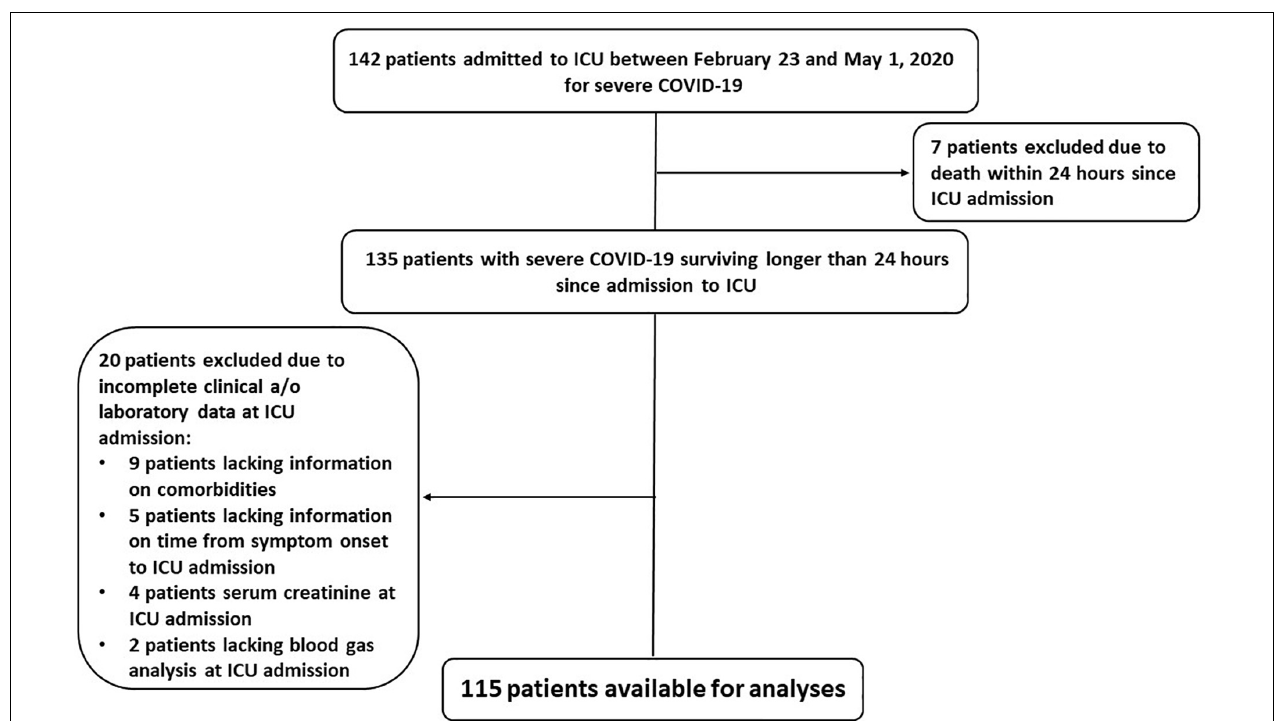
FIGURE 1 | Flow chart of the process of selection of the study